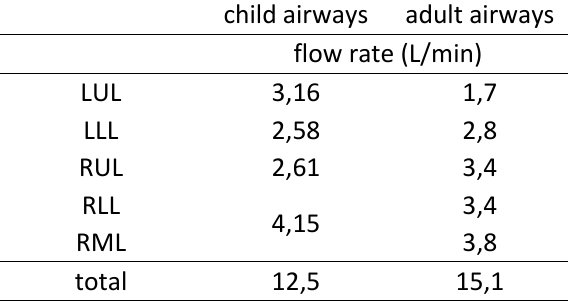
Table 1. Flow rates through respiratory airway models